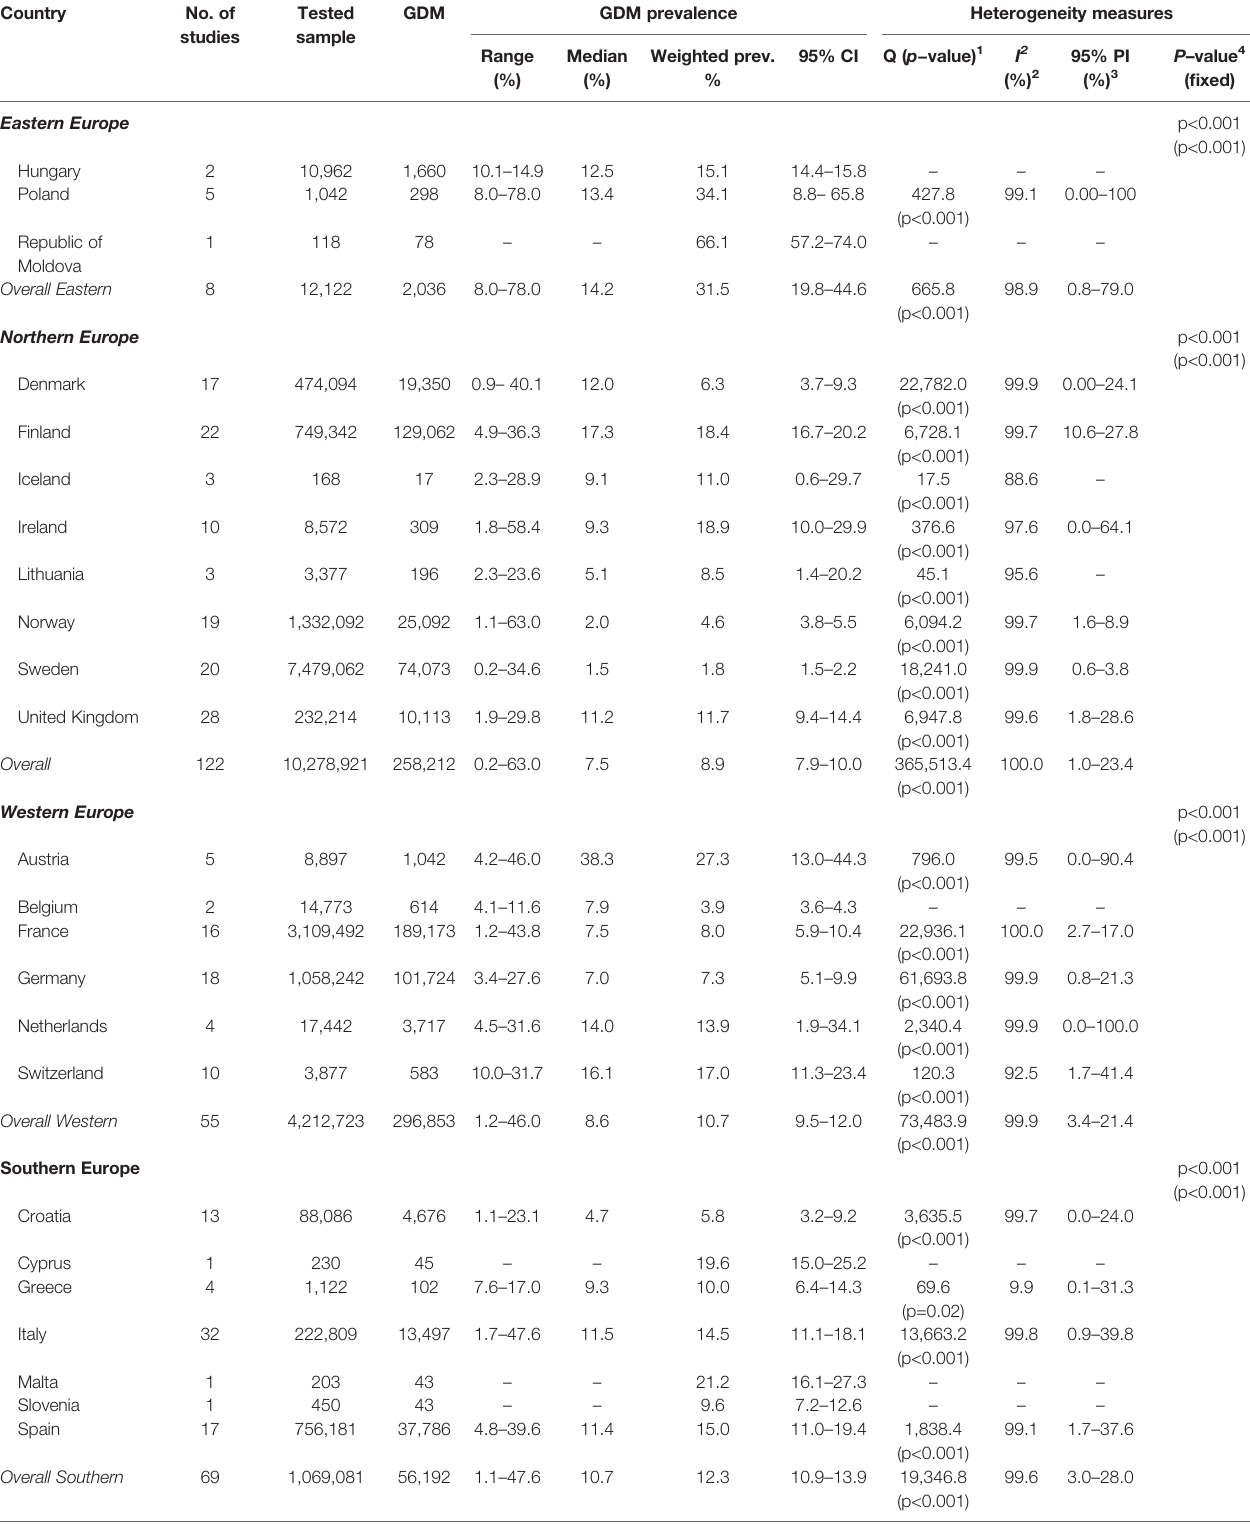
TABLE 5 | Weighted national, sub – regional, and regional GDM prevalence in Europe.